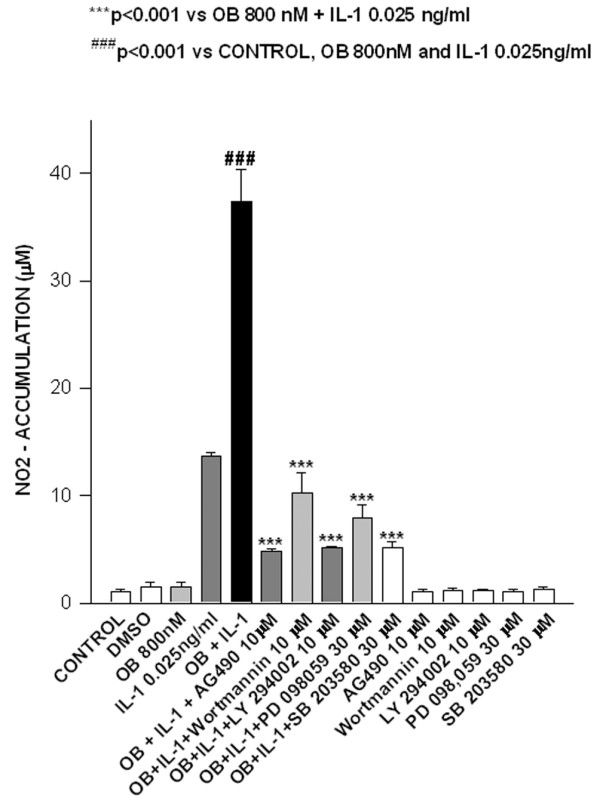
Leptin acts synergistically with IL-1 in human primary chondrocytes. Nitrite (NO2-) accumulation in leptin (OB)/IL-1 co-stimulated human primary chondrocytes. Stimulations were conducted in serum-free conditions in the presence or absence of tyrphostin AG490, wortmannin, LY294002, PD98059 and SB203580 inhibitors. Values are expressed as mean ± standard error of the mean.